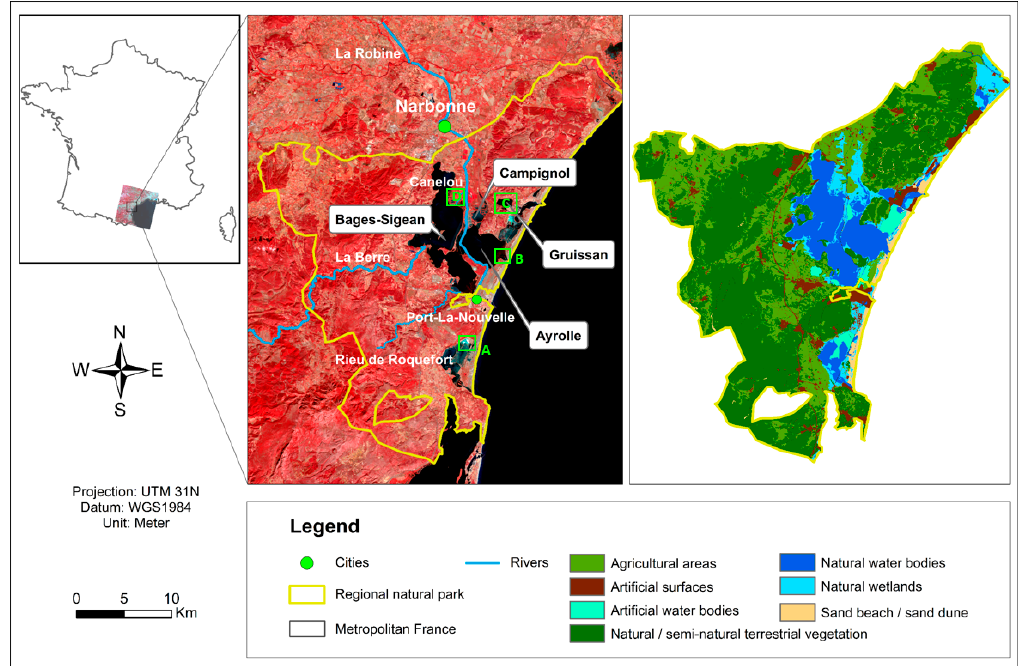
Figure 1. Location of the Regional Natural Park of Narbonne and the spatial distribution of main elements of the lagoon complex. The left part represents the geographic location of the study area, while the middle part represents the Landsat 8 OLI (date: 10-04-2017) false-color composite (FCC) image using the Green, Red and NIR bands. The right part represents the land use and land cover (LULC) map of 2012 (OCSOL2012 © GN / PNR, Licence ODb). The four blocks in green represent the areas of interest for qualitatively evaluating the spectral indices used in surface water extraction in this study.